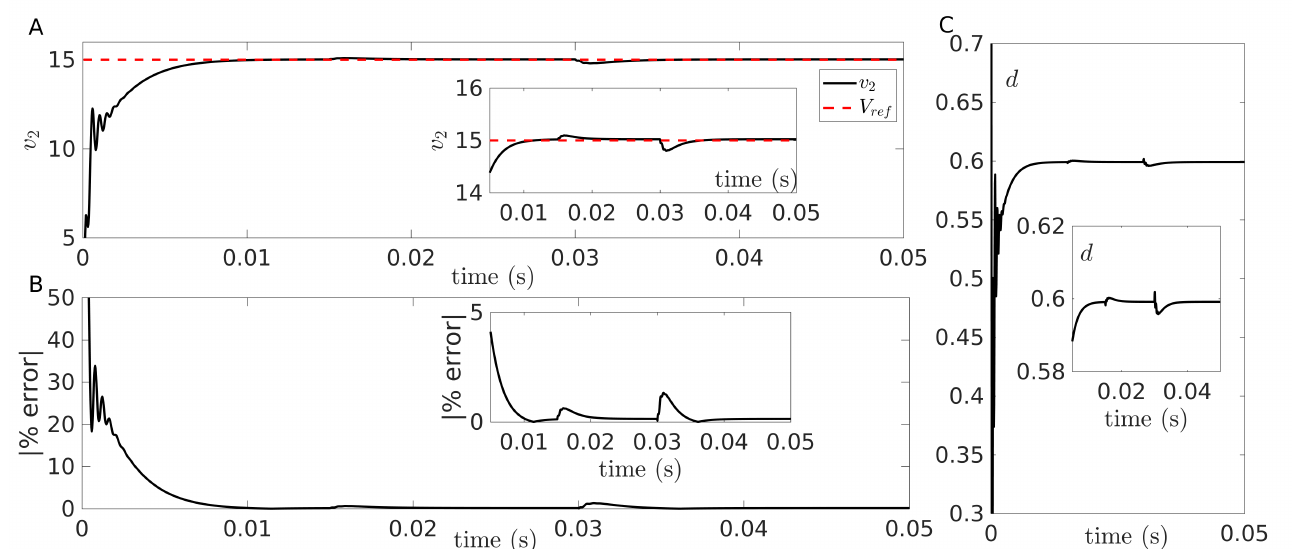
Figure 7. Time trace of the ramp controlled sZETA converter under perturbations of the load: ( A ) voltage trace; ( B ) error percentage; and ( C ) duty cycle. In all panels, R = 100 Ω for t < 15 ms, R = 200 Ω for 15 ms ≤ t < 30 ms, and R = 50 Ω for t ≥ 30 ms.